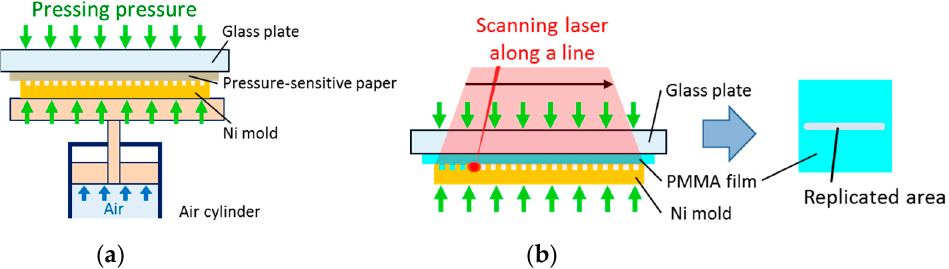
Figure 3. Schematics of ( a ) measurement of the pressing pressure and ( b ) replication by scanning the laser along a line.